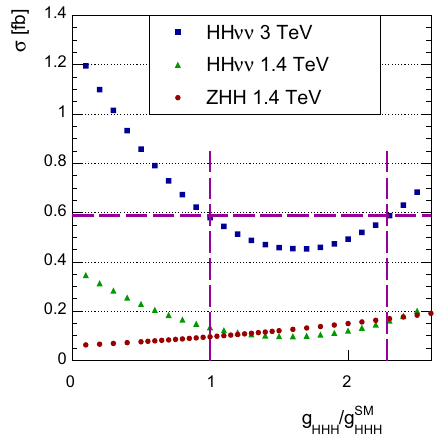
Fig. 3 Cross section dependence of the trilinear Higgs self-coupling for the processes HH ν ¯ ν production at 1.4 and 3TeV and ZHH produc- tion at 1.4TeV for unpolarised beams. Beamstrahlung and initial state = 1. The ambiguity radiation are included. The SM case is at g HHH g SM HHH